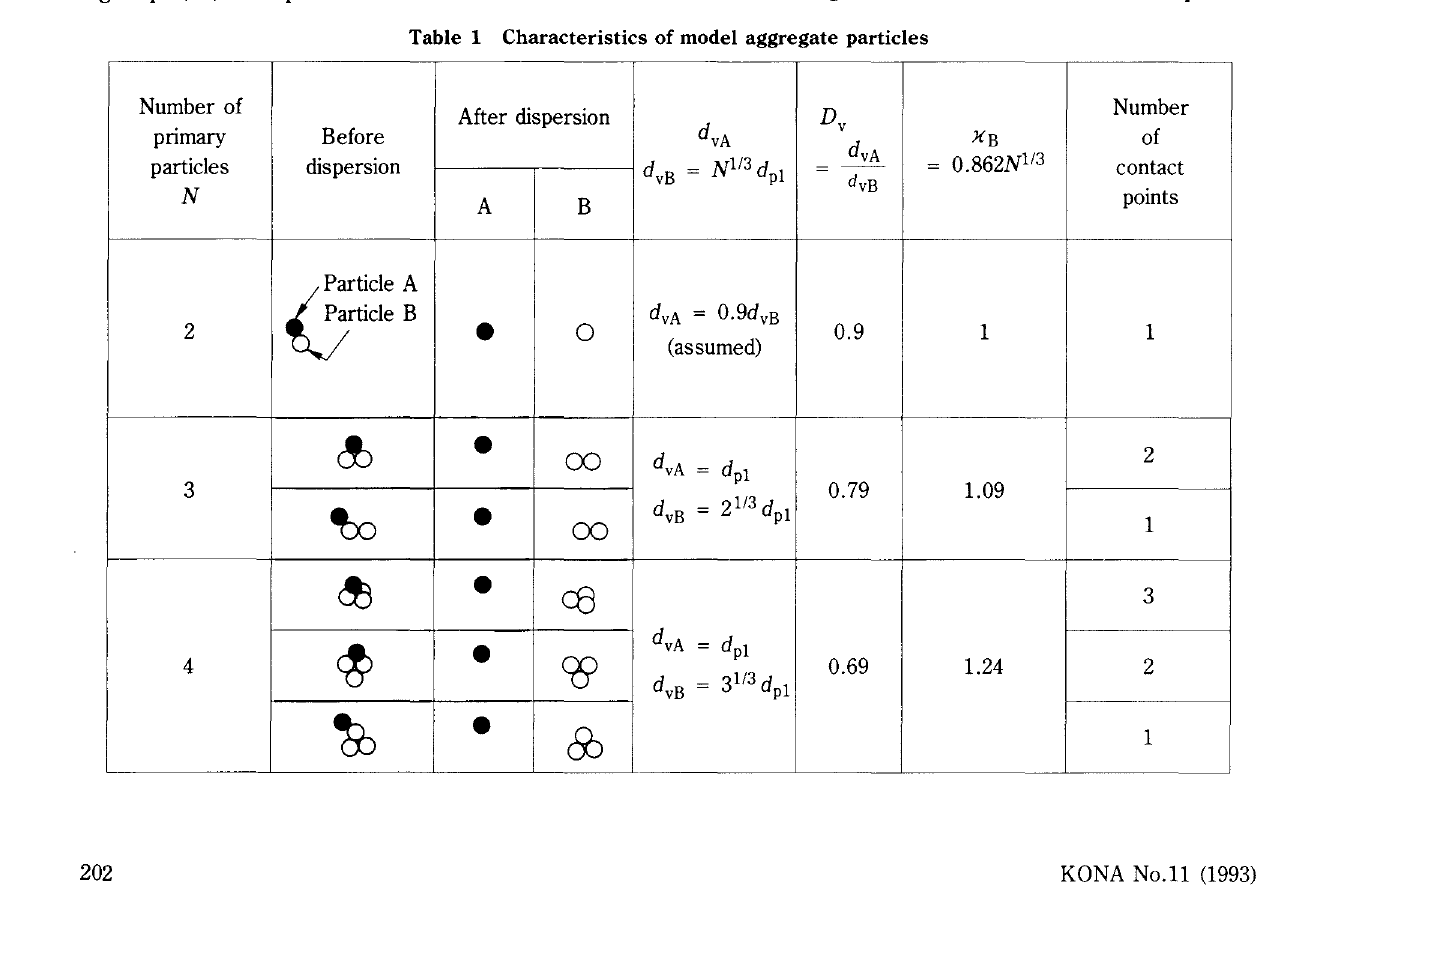
Table 1 Characteristics of model aggregate